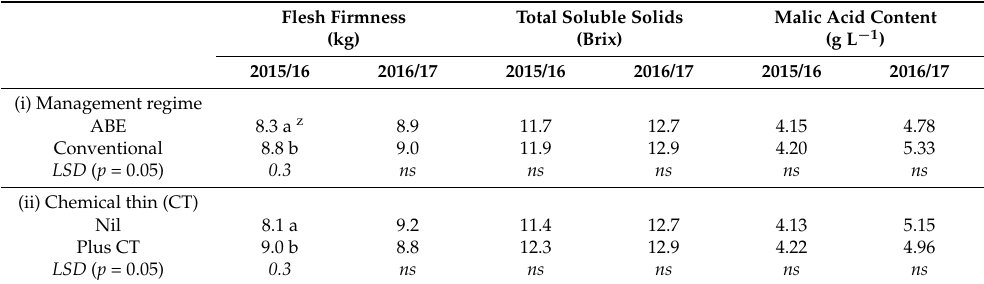
Table 13. Effect of management regime and thinning method on fruit firmness, total soluble solids and malic acid content of ‘Fiero Fuji’ (Trial 3). ABE = artificial bud